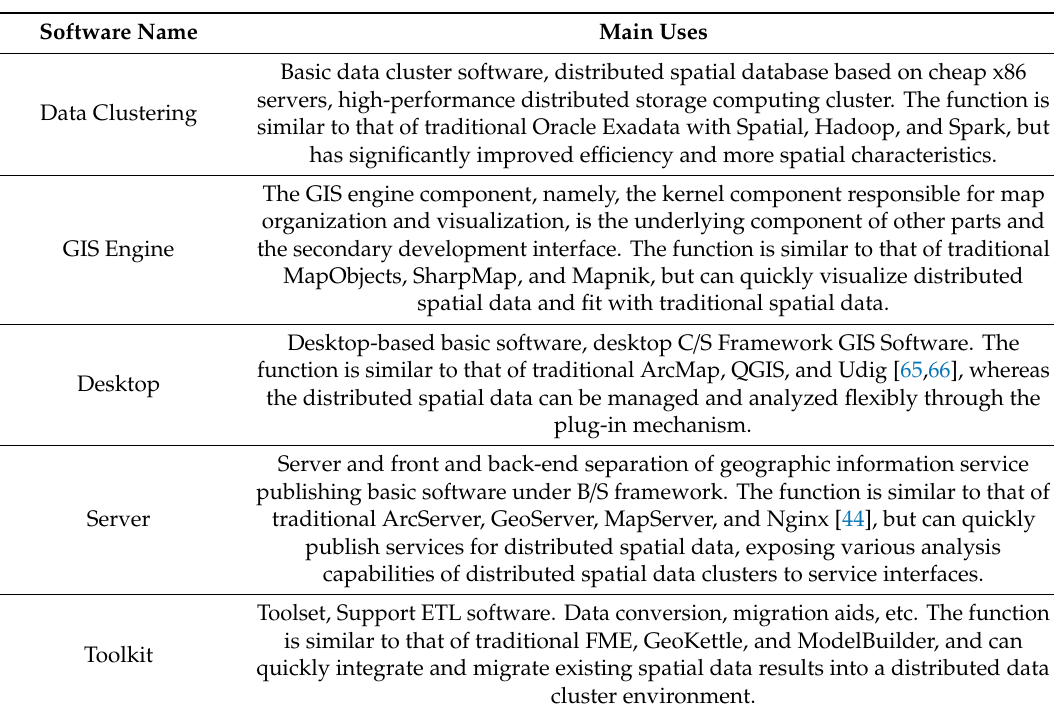
Table 1. BiGeo Table 1. BiGeo software.